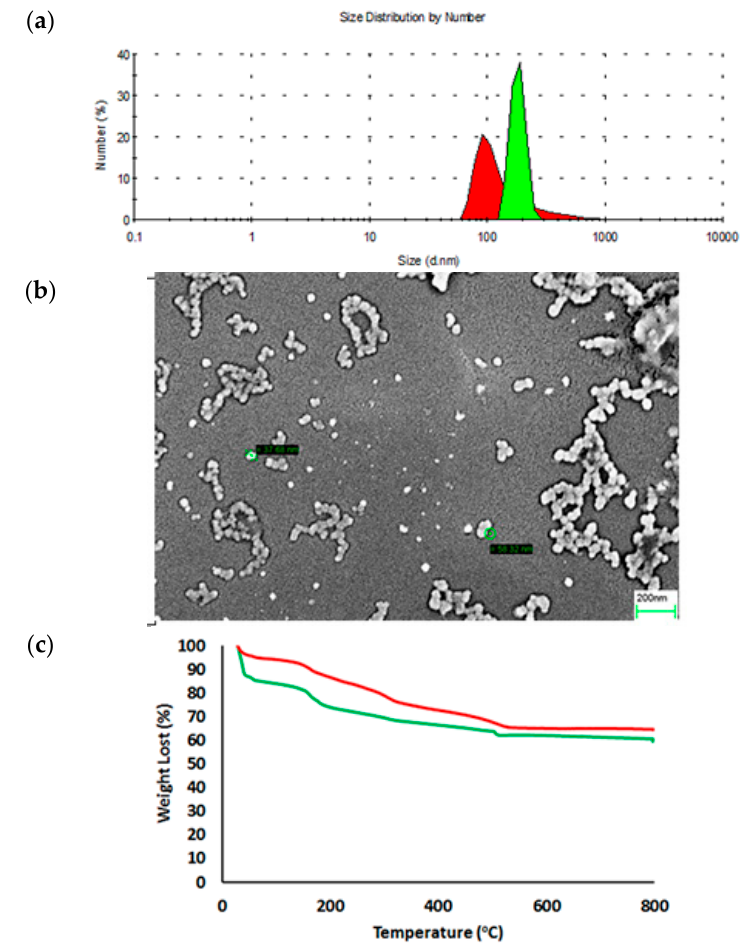
Figure 2. Structural properties of C-TCPP- and RR-TCPP-PSilQNPs. ( a ) Dynamic light scattering plot of C-TCPP- (green) and RR-TCPP-PSilQNPs (red); ( b ) SEM image of C-TCPP-PSilQNPs (green circles show the diameter of individual nanoparticles); Scale bar = 200 nm; and ( c ) Thermogravimetric analysis (TGA) plot of C-TCPP- (green) and RR-TCPP-PSilQNPs (red).